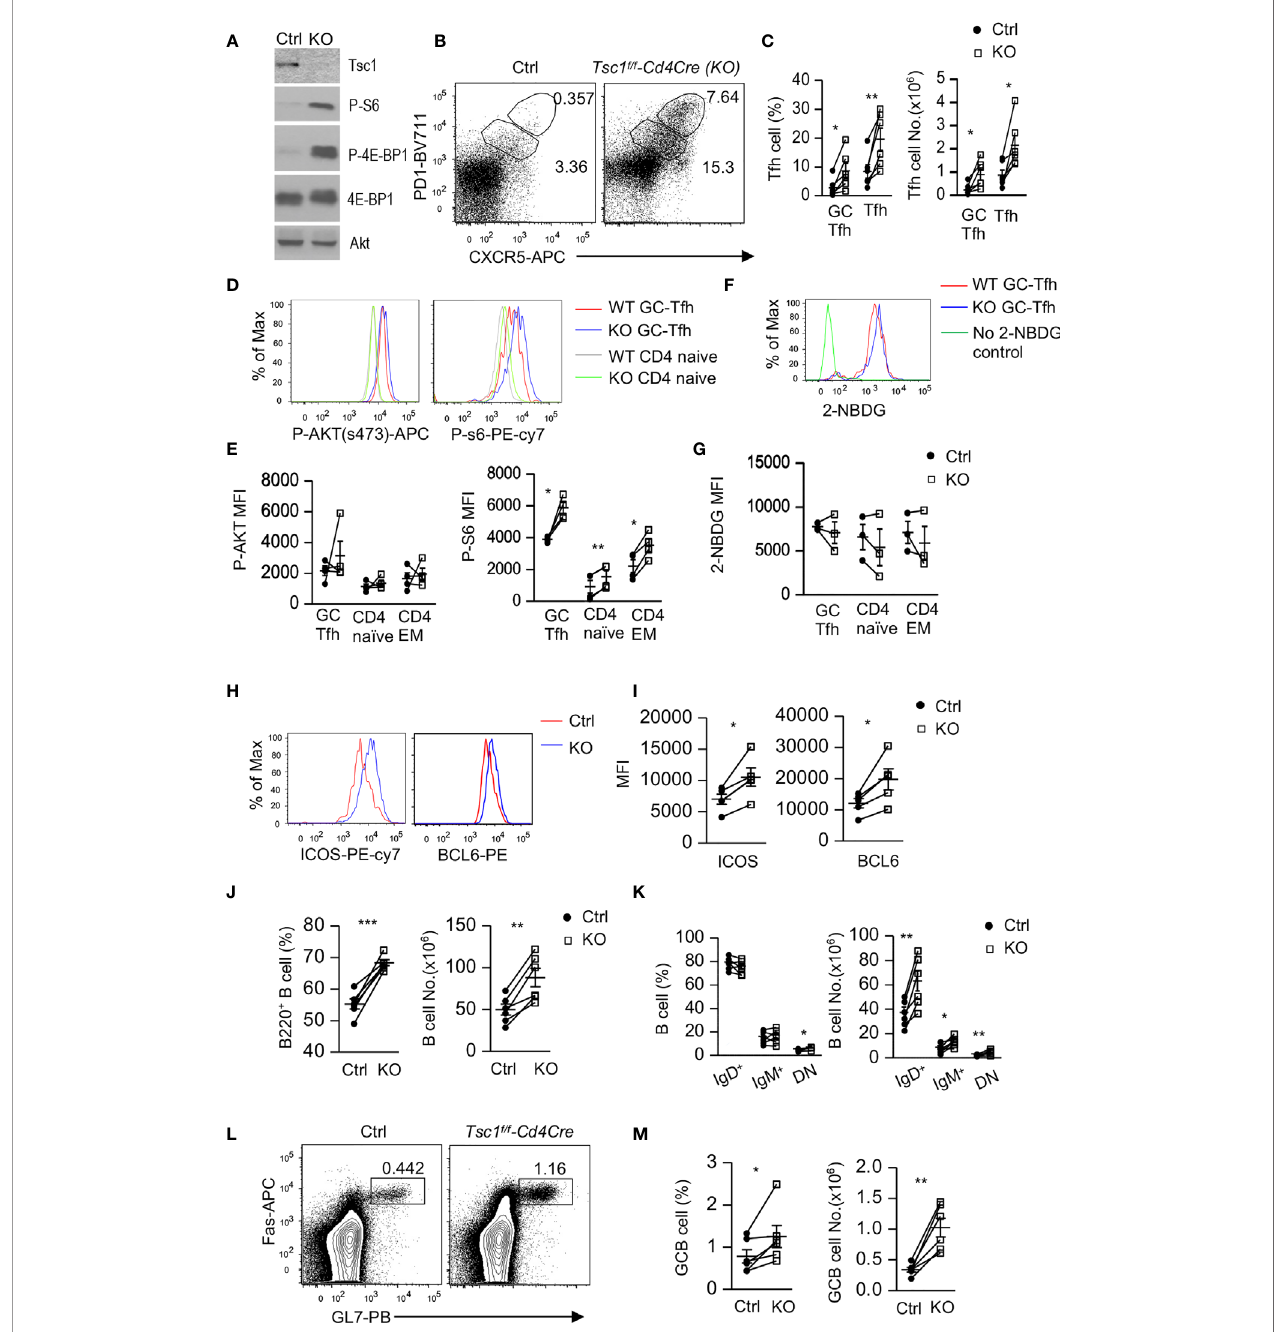
FIGURE 1 | Inhibition of Tfh and GC responses by Tsc1. Splenocytes from 8 – 10 weeks old Tsc1 f/f Cd4Cre and WT control mice were analyzed. (A) Immunoblotting of puri fi ed CD4 T cell lysates with the indicated antibodies. (B) Representative dot-plots of CXCR5 and PD1 staining in gated CD4 + TCR b + Foxp3 - T-cells. Gating strategies for GC-Tfh, Tfh, Treg, Tfr, naïve, CD44 + CD62L + central memory (CM), CD44 + CD62L - effector memory (EM) CD4 T cells are shown in Supplementary Figure 1 . (C) Scatterplots represent mean ± SEM of GC-Tfh and Tfh cell percentages and numbers. (D) Overlaid histograms show Akt and S6 phosphorylation in CD4 + TCR b + Foxp3 - naïve and GC-Tfh cells. (E) Scatterplots represent mean ± SEM of mean fl uorescence intensity (MFI) of phosphor-Akt and – S6 in CD4 + TCR b + Foxp3 - T cell populations. (F) Overlaid histograms show 2-NBDG uptake in GC-Tfh cells. (G) Scatterplots represent mean ± SEM of 2-NBDG MFI in CD4 + TCR b + Foxp3 - T cell populations. (H) Overlaid histograms show Bcl6 and ICOS levels in GC-Tfh cells. (I) Scatterplots represent mean ± SEM of Bcl6 and ICOS MFI in GC-Tfh cells. (J) Scatterplots show percentages and numbers of B220 + B cells. (K) Scatterplots show mean ± SEM of percentages and numbers of indicated B cell populations. (L) Representative dot-plots show GL7 and Fas staining in gated CD93 - B220 + B cells. (M) Scatterplots represent mean ± SEM of GC-B cell percentages and numbers. Data represent or are pooled from 3 – 6 experiments. * p < 0.05; ** p < 0.01, *** p < 0.001 determined by a pairwise two-tailed Student t